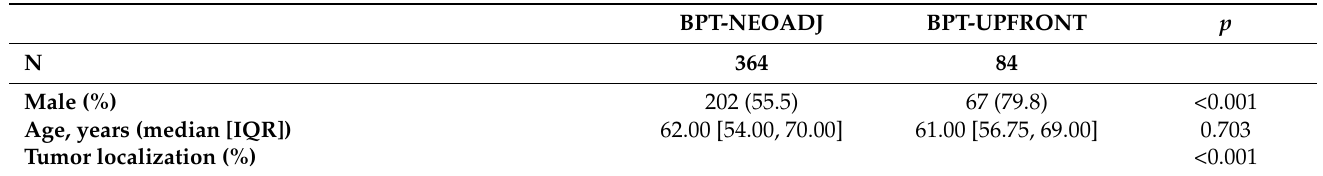
Table 2. Baseline characteristics of the best potential treatment cohorts estimated after the creation of the model for mortality risk by